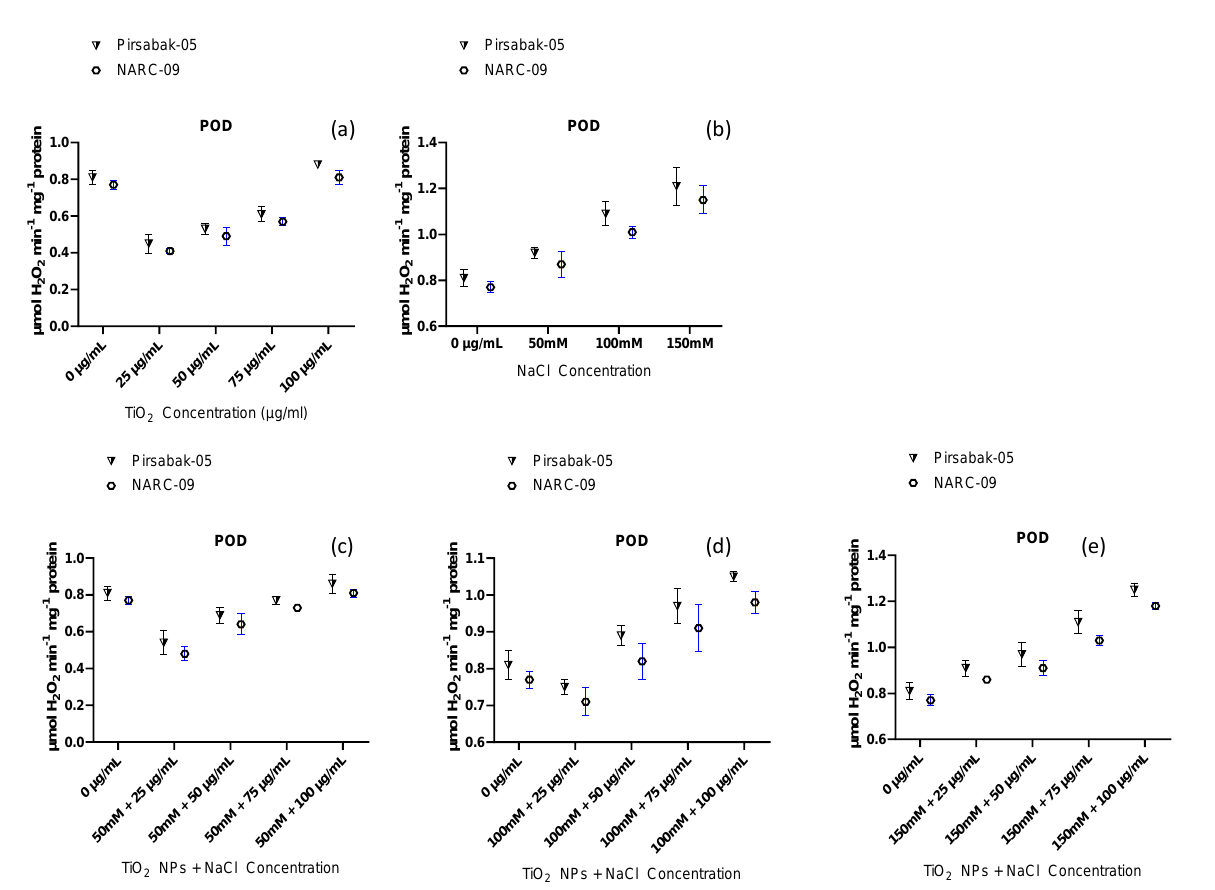
Figure 9. Effects of biogenic TiO 2 NPs on peroxidase dismutase (POD) activity for wheat varieties under salinity stress conditions; ( a ) Effect of different concentrations of biogenic TiO 2 NPs on wheat varieties, ( b ) Effect of different concentrations of NaCl on wheat varieties, ( c – e ) Effect of different concentrations of TiO 2 NPs under varied concentrations (i.e., 50 mM, 100 mM, and 150 mM of NaCl). The data are represented in the form of means, while p was kept at p ≤ 0.05.